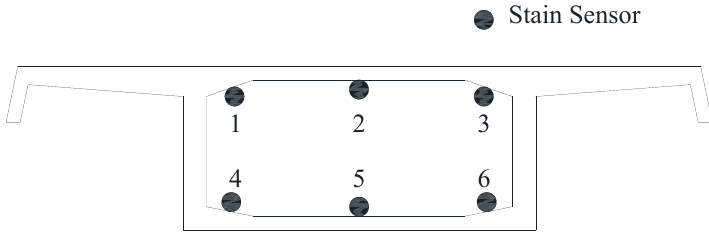
Figure 3. The layout diagram of strain sensors on the surface of concrete.